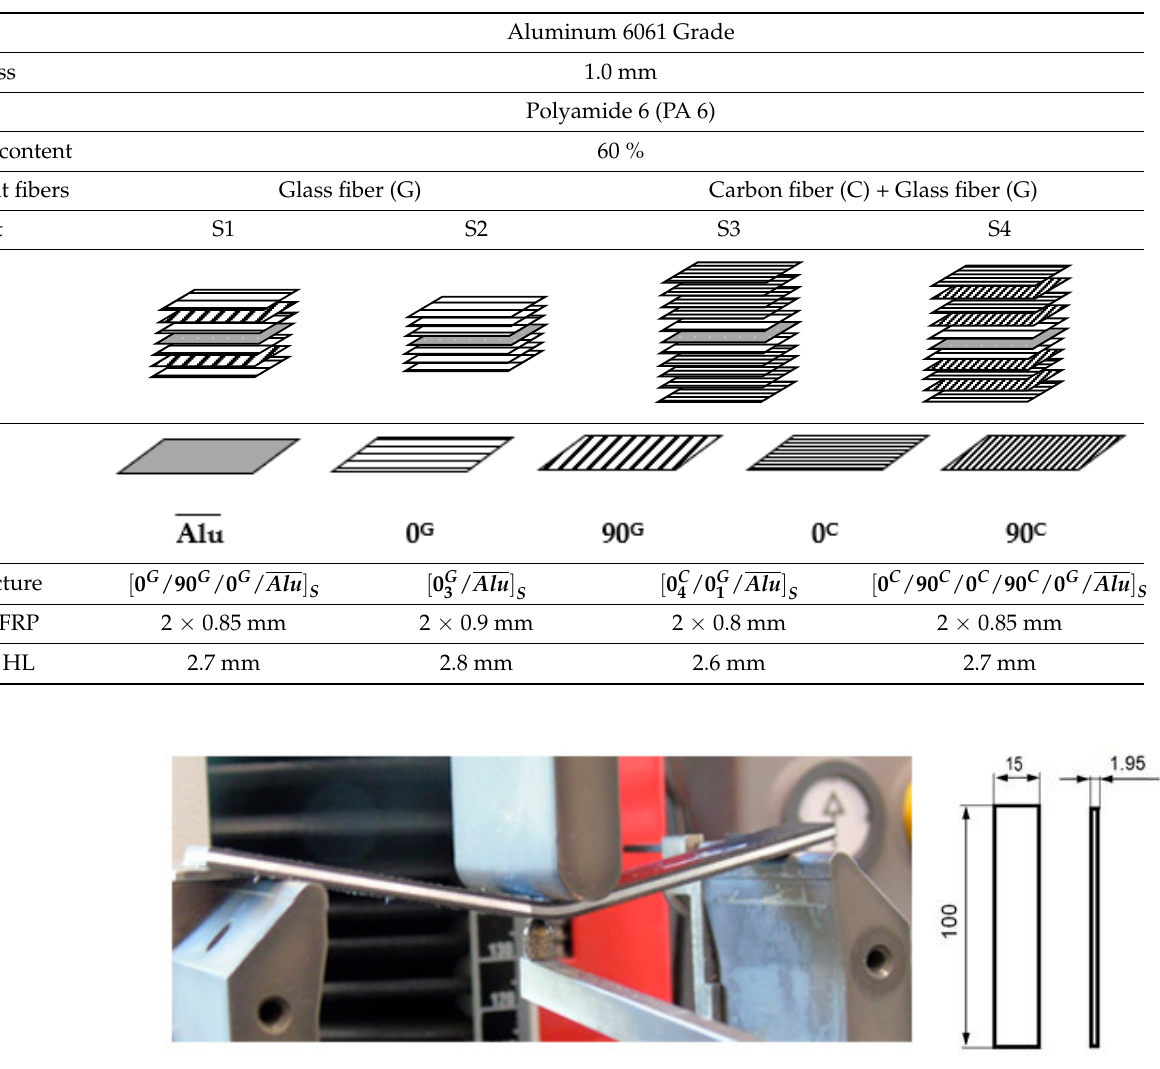
Table 1. Structure of the investigated inverse hybrid laminates.